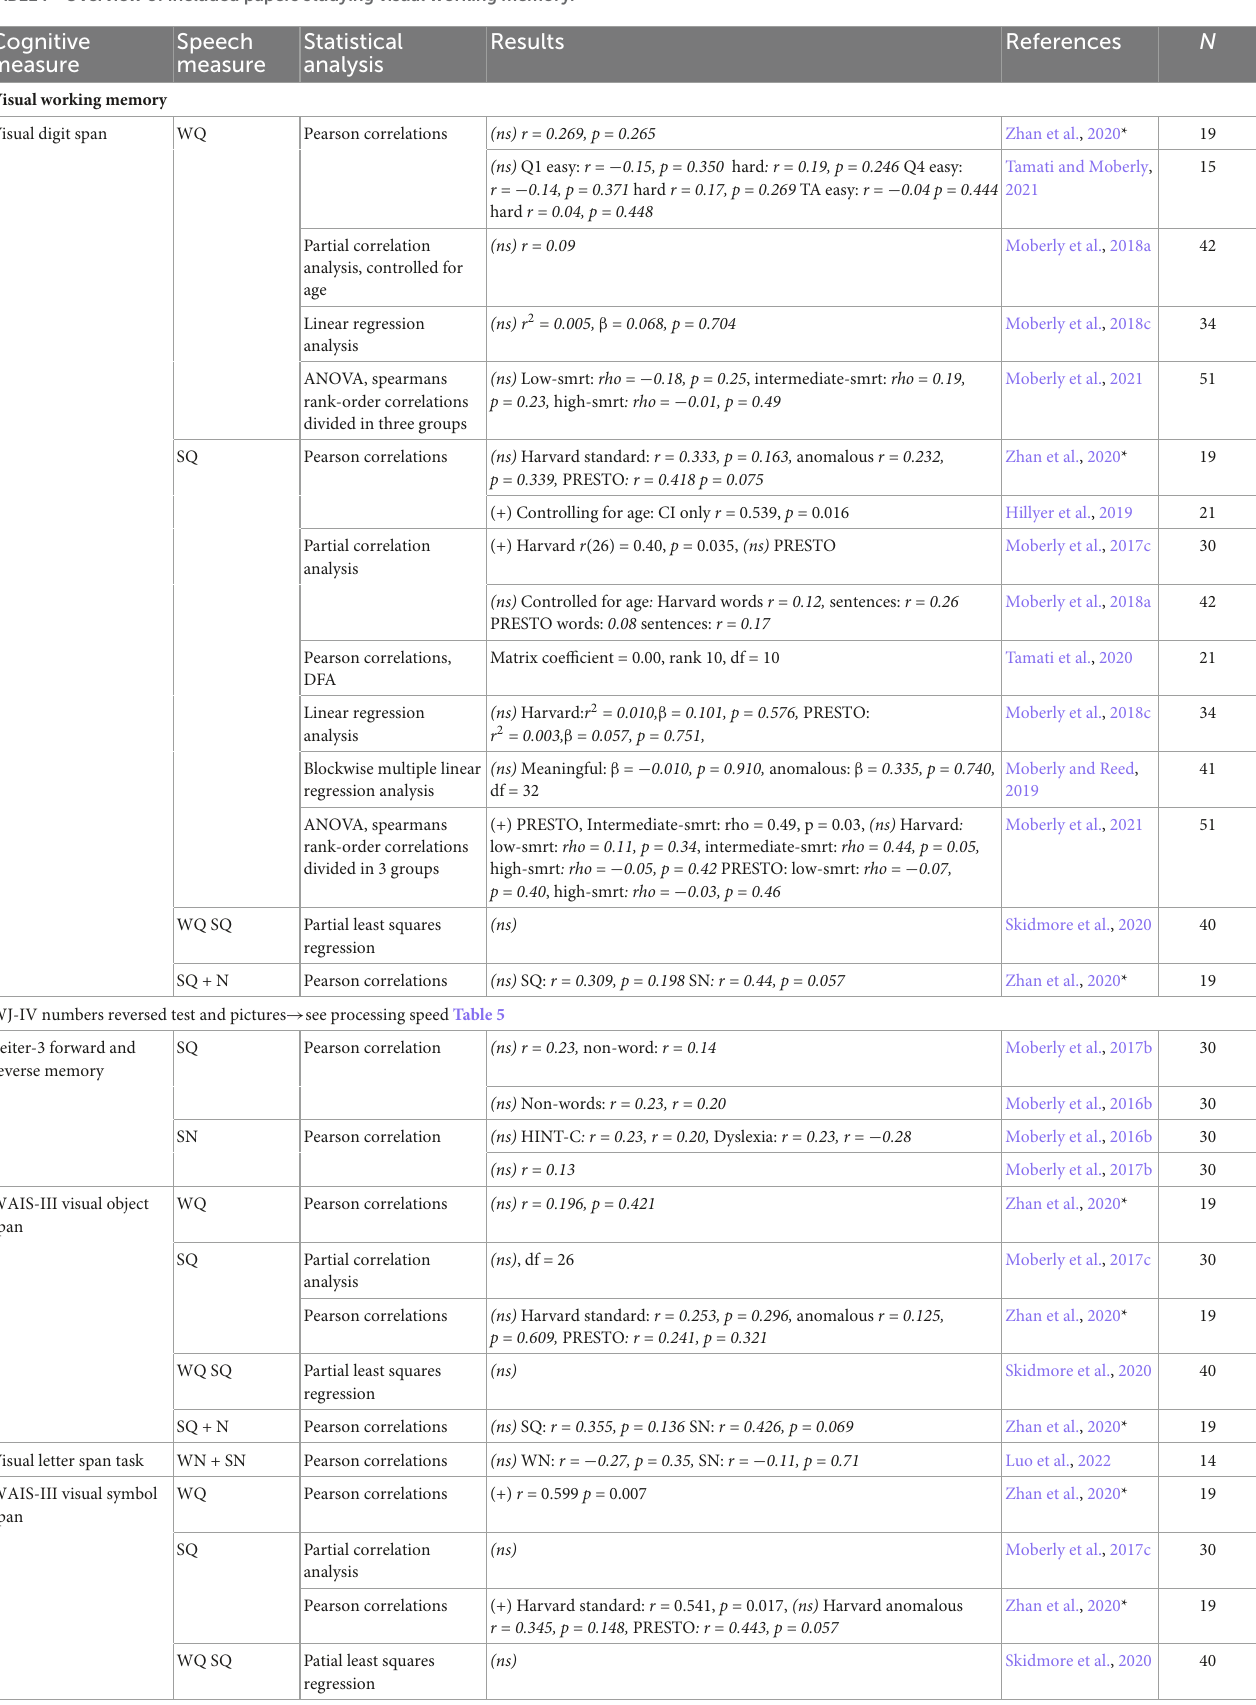
TABLE 7 Overview of included papers studying visual working